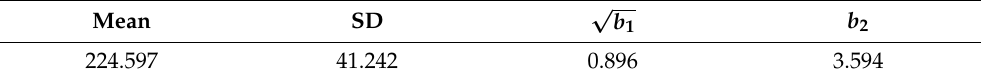
Table 3. Summary statistics for cholesterol levels for 176 subjects of the Framingham cholesterol study. Mean